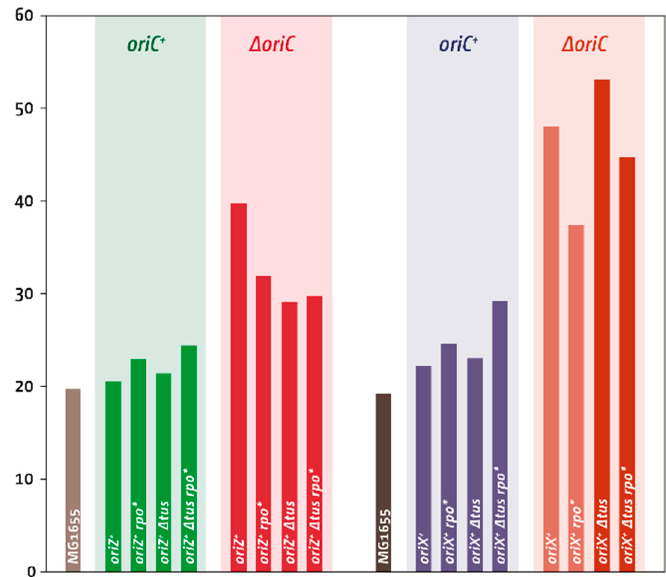
Figure 4. Comparison of doubling times of oriZ + constructs, as reported in [18], and oriX + constructs (this study). The presence or absence of oriC is highlighted above each group of strains. The ectopic origin and all other genotype details are identified for each strain individually. The two ∆ oriC oriX + constructs, identified by a lighter colour, contained large chromosomal inversions (see main text for details). All doubling times were determined by measuring viable titres of cultures grown in Luria broth (LB) (see Material and Methods for details).